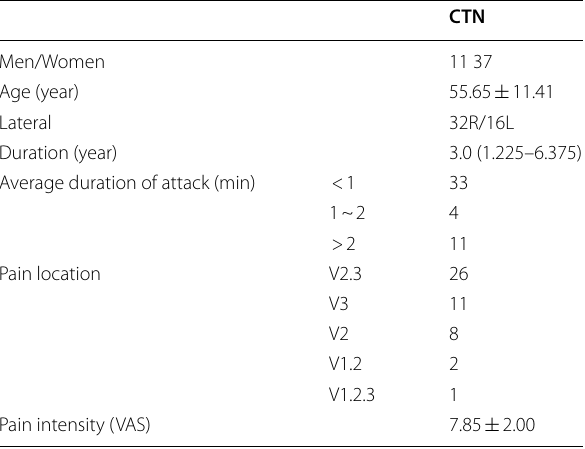
CTN Classical trigeminal neuralgia, VAS Visual Analogue